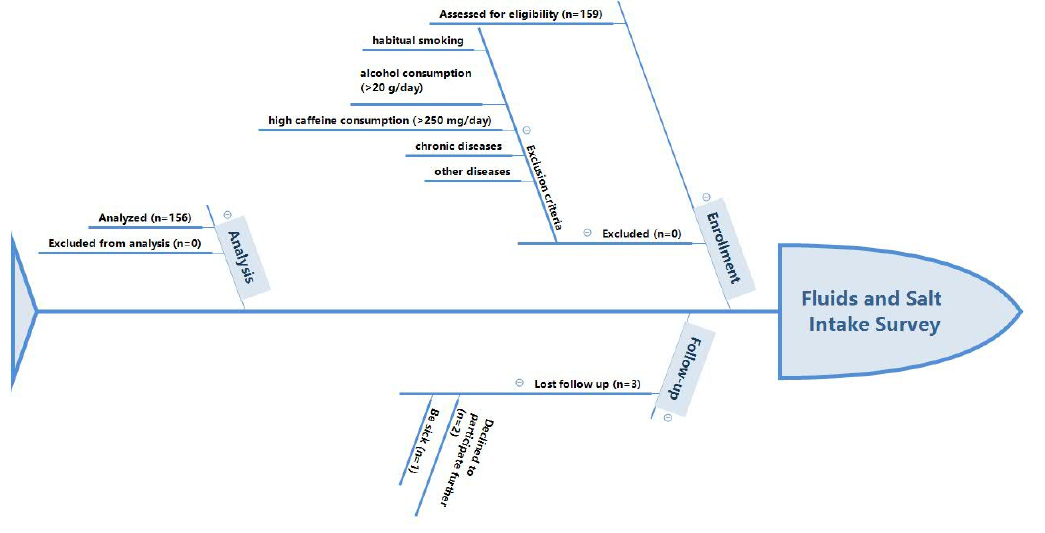
Figure 1. Participants flow chart.